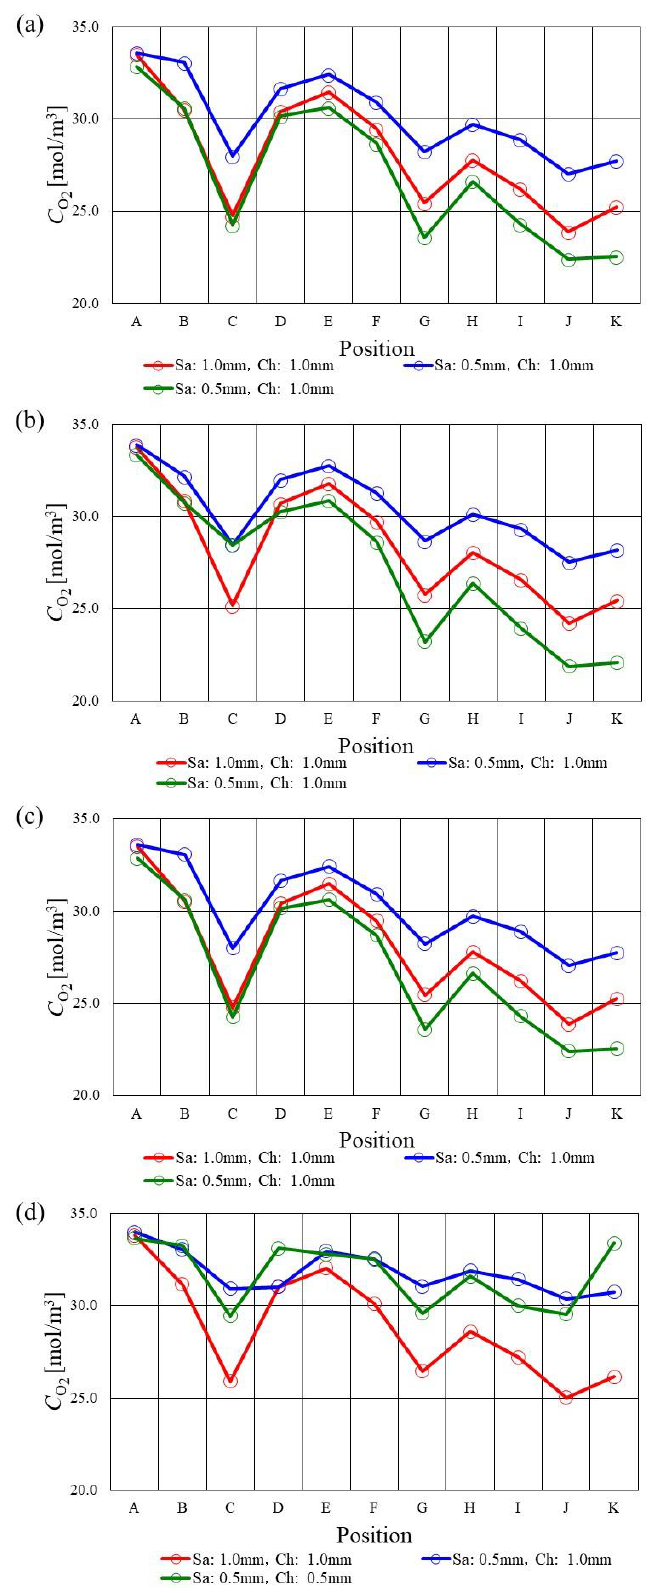
Figure 5. Molar concentration of O 2 along with the gas channel on the interface between PEM and catalyst layer at the cathode among various s.t. at T ini = 353 K. ( a ) A80%RH/C80%RH, ( b )